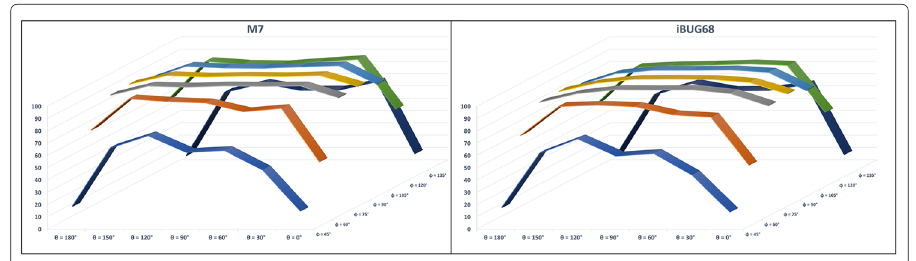
Fig. 11 PRNet: camera position varying across φ (from 45 ◦ to 135 ◦ ) and θ (from 0 ◦ to 180 ◦